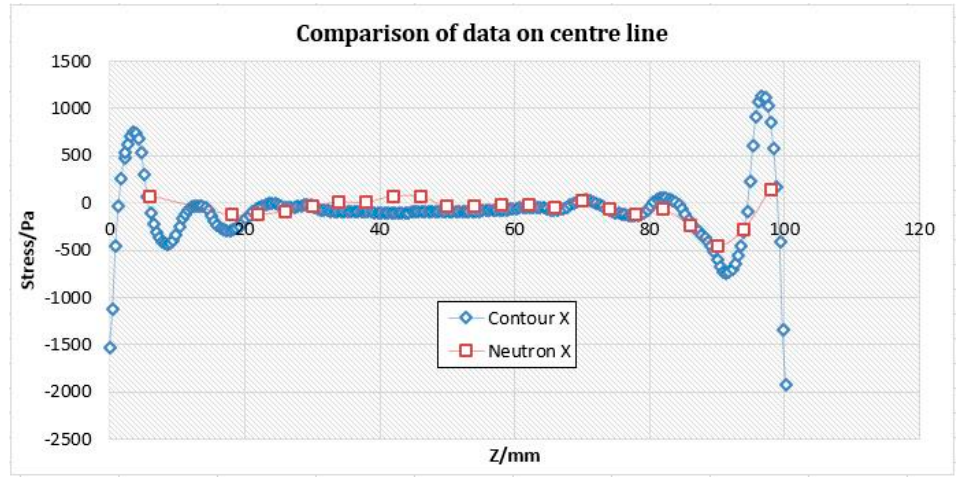
Figure 11. Comparison of residual stress measurements with the contour method (blue) and neutron diffraction (red).